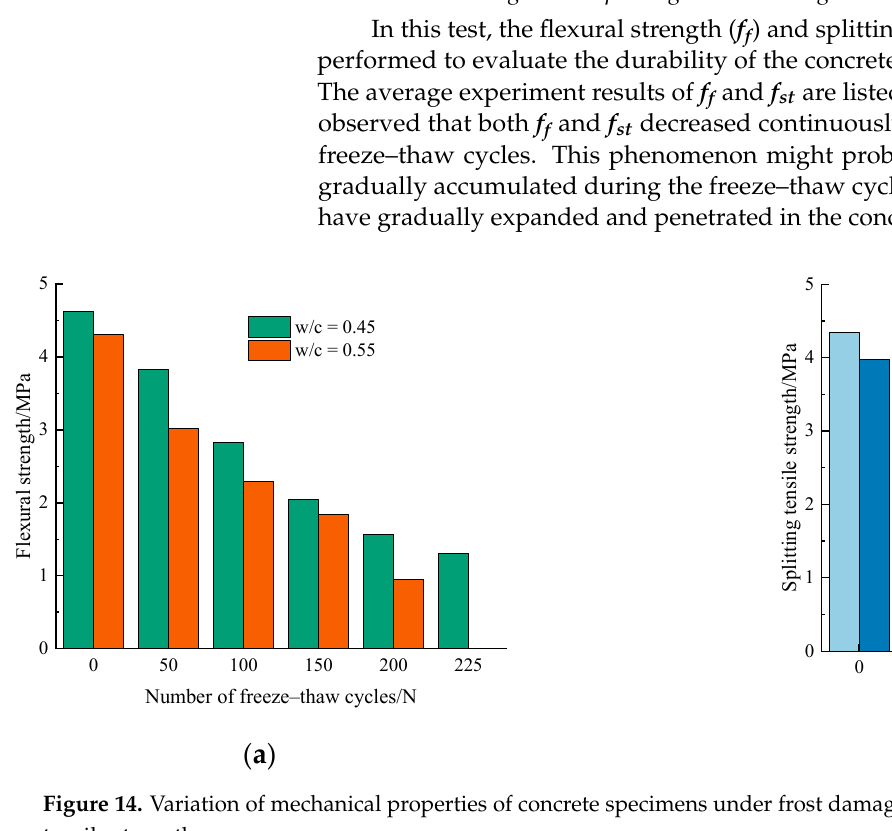
tensile ting tensile strength.